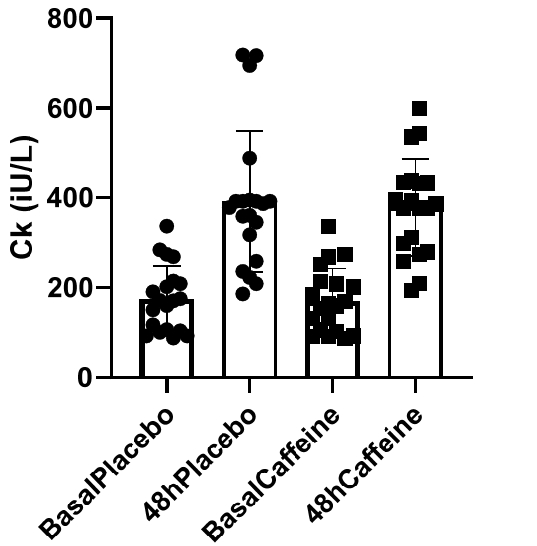
Figure 4. CK: Caffeine vs. Placebo.